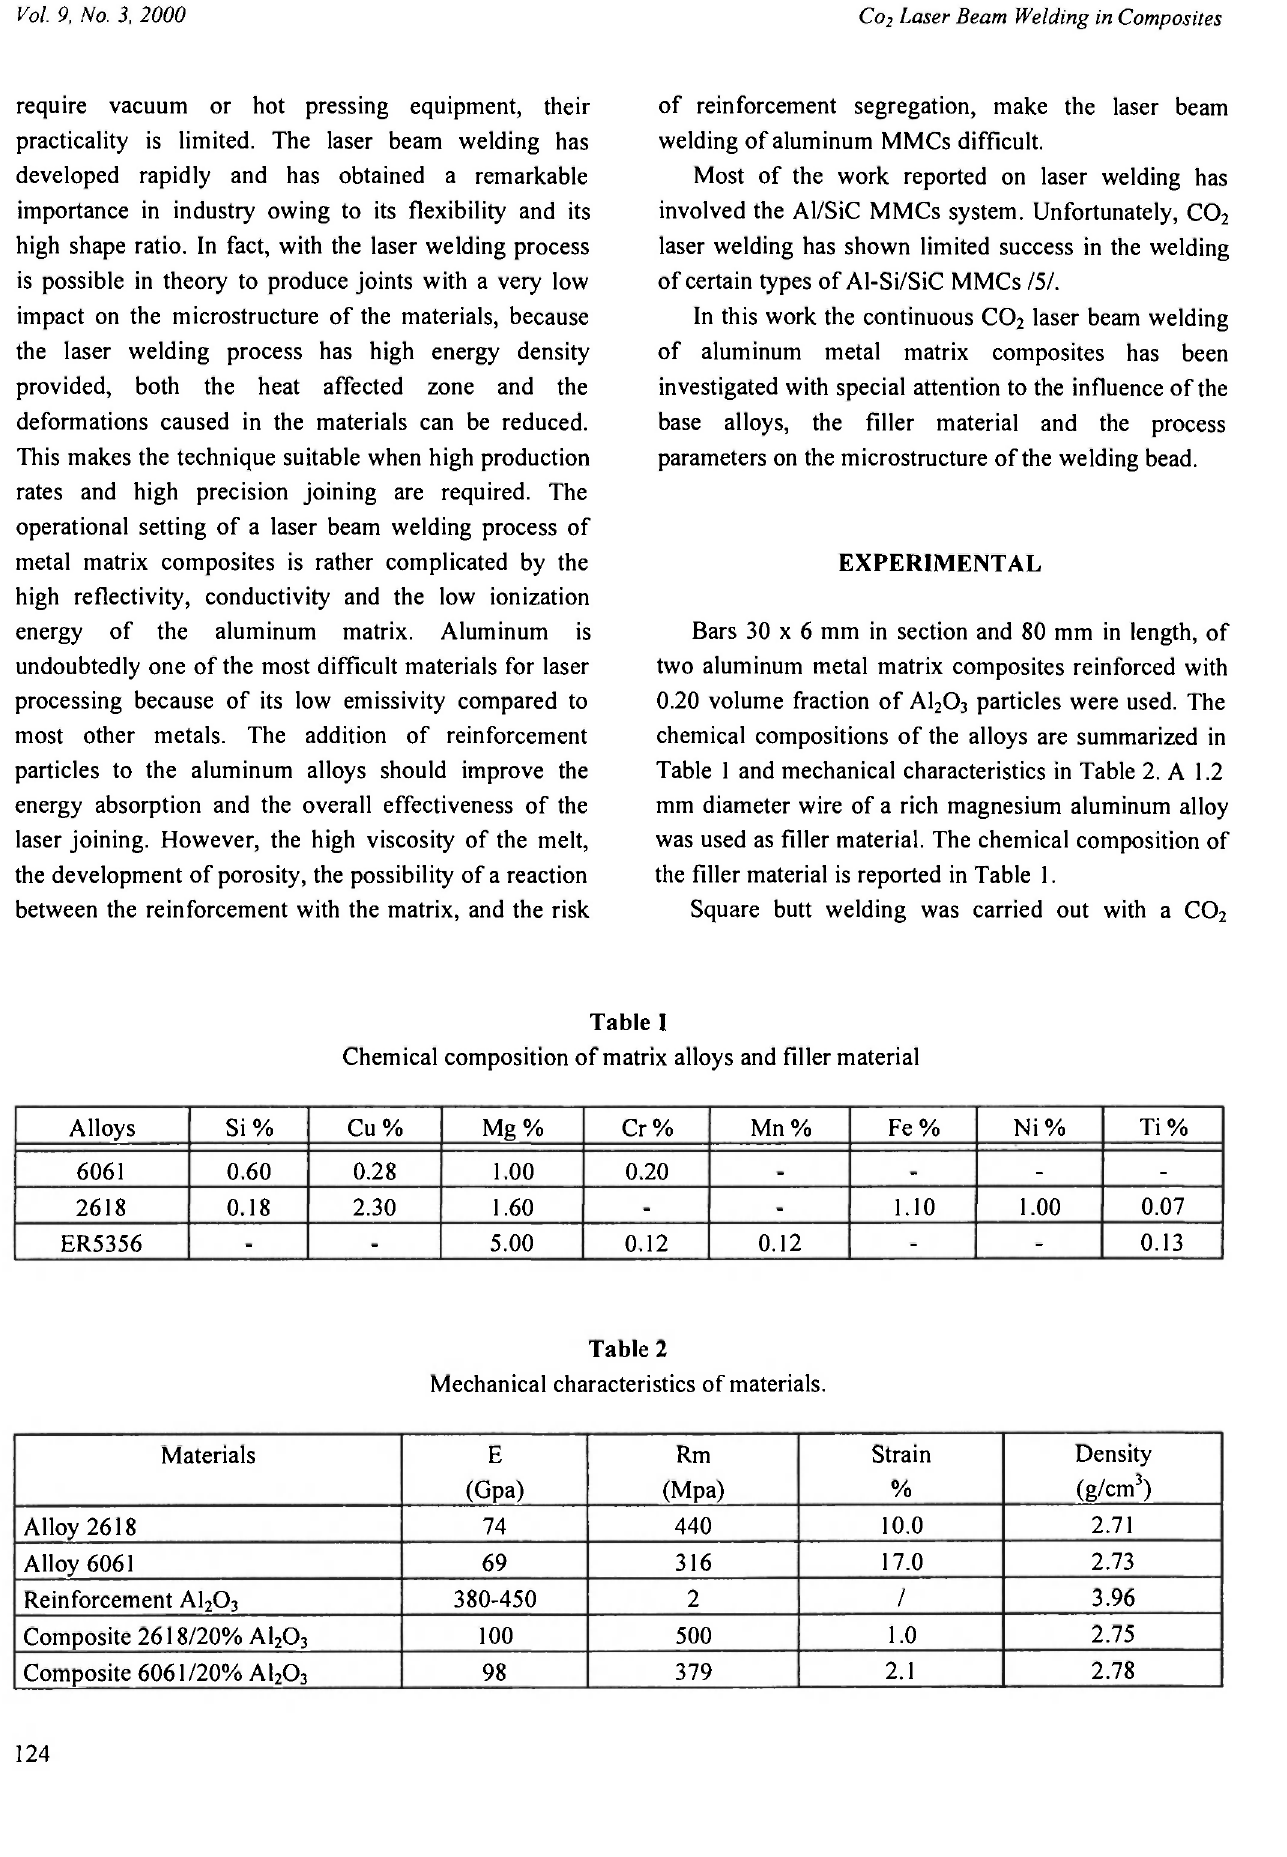
Mechanical characteristics of